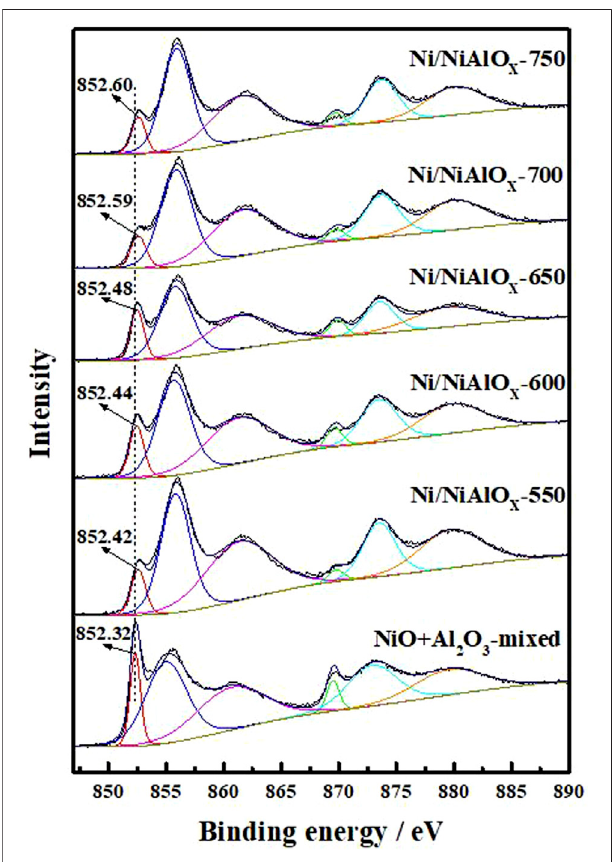
FIGURE3| XPSspectraintheNi2P 3/2 regionofNi/NiAlO y catalystswith different calcination temperatures.